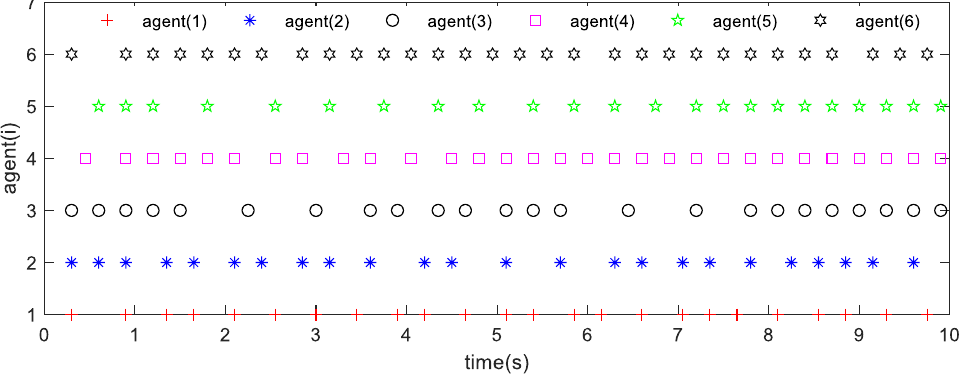
Figure 9. Event times for each agent.